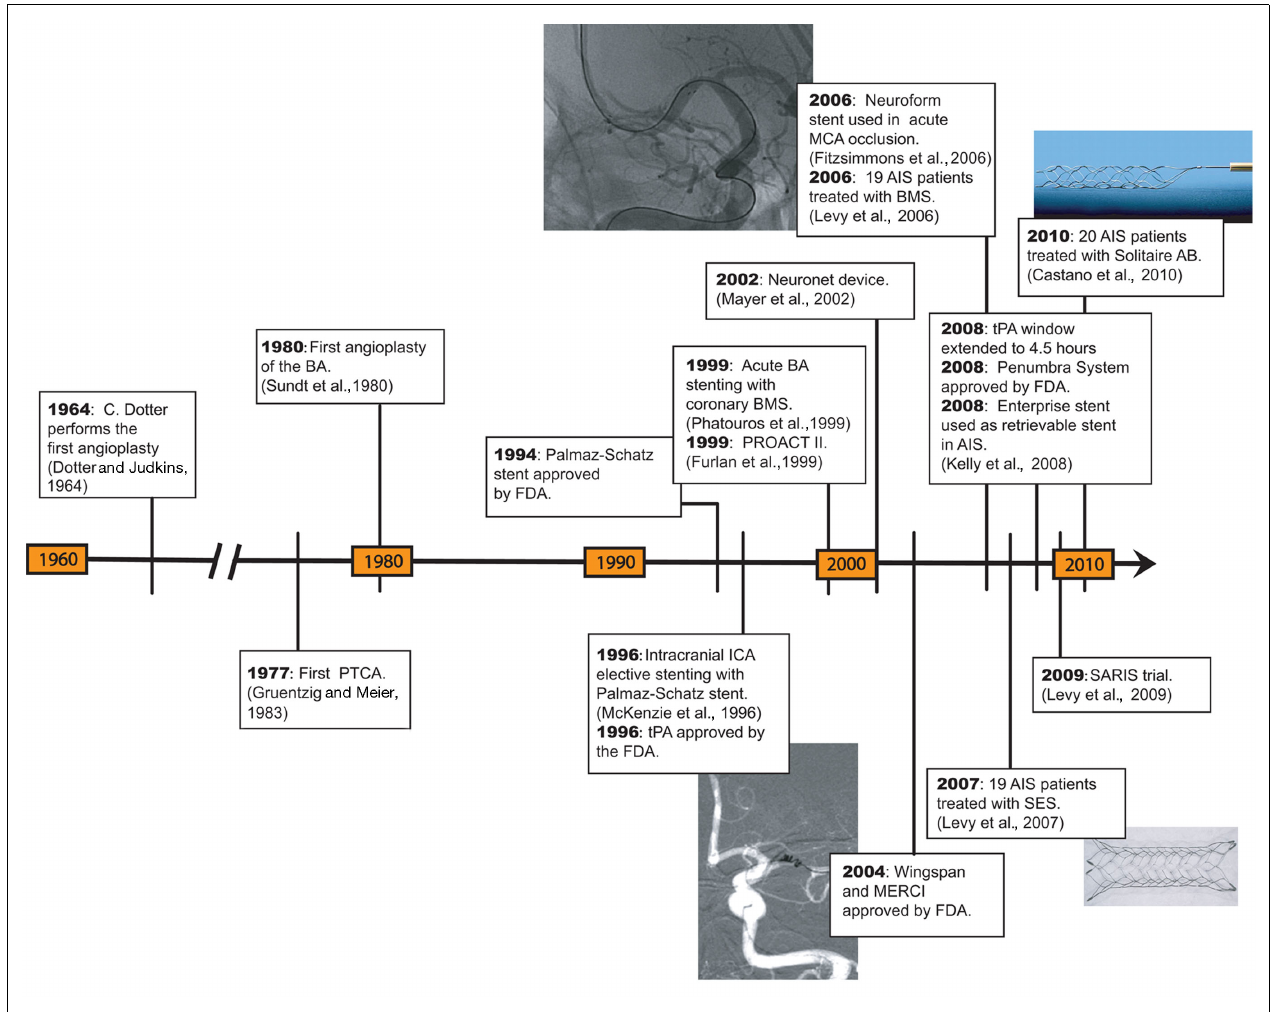
FIGURE 4 | Rapid evolvement of stroke therapies during the last 20years.